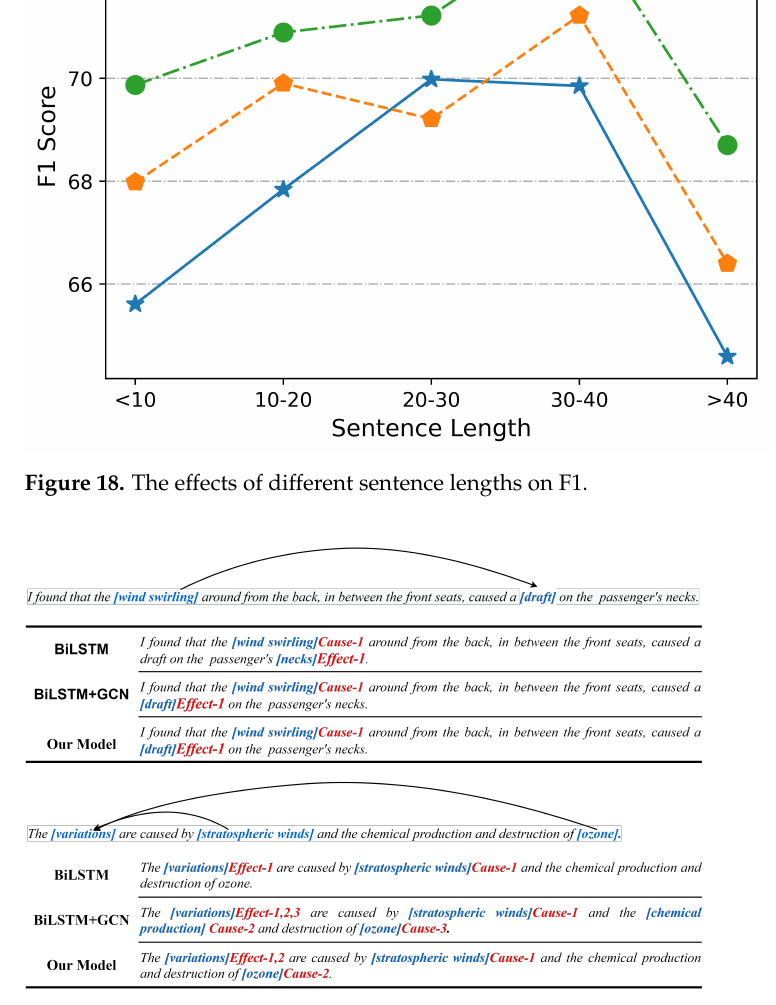
Figure 19. The automatic labeling result of the test sentence pattern. The blue word indicates the causal entity after model labeling, and Cause/Effect-X indicates the X-th causal pair in the sentence